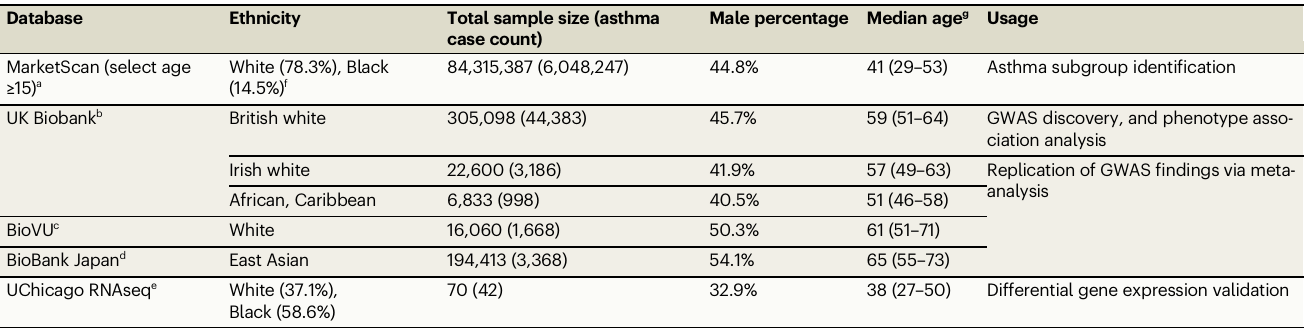
Fig.1|Identi fi cationofasthmasubgroupsthroughtopicmodeling.a Flowchart of asthma subgroup identi fi cation. The MarketScan data includes around six